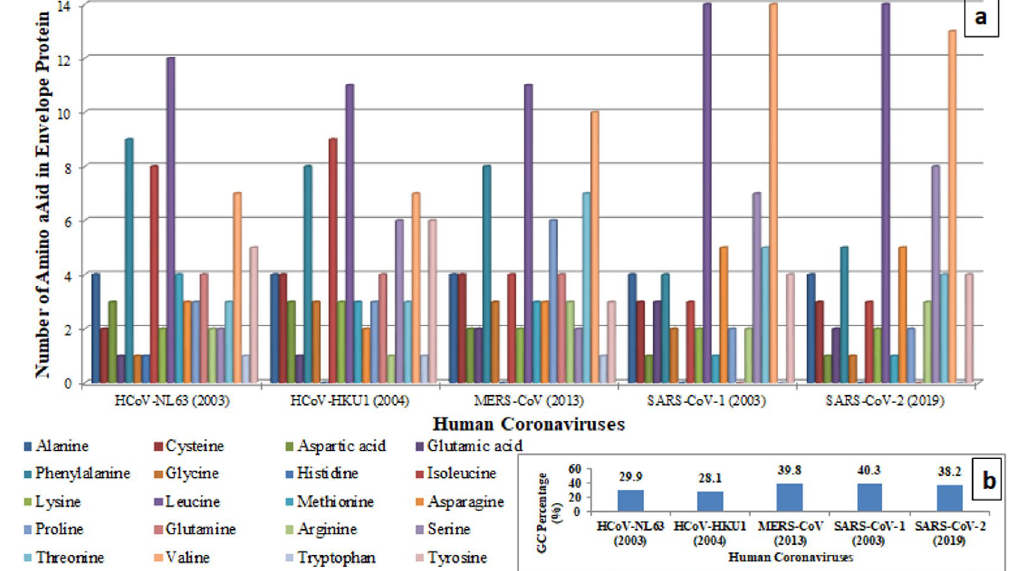
Fig. 2. Abundance of Amino Acids Envelope Protein (a)and GC percentage of Envelope Protein gene sequence(b) among Human